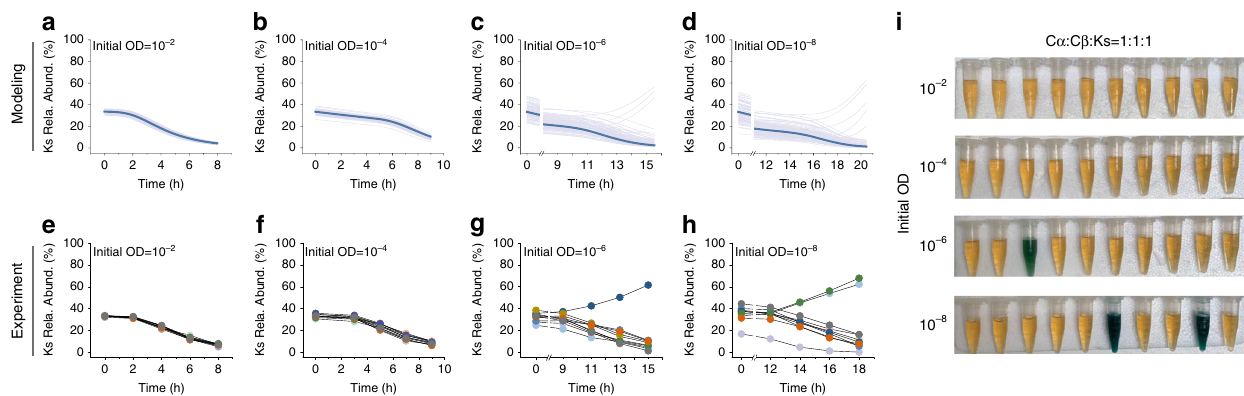
Fig. 4 Divergent ecosystem dynamics directed by cooperation variations from sampling. a – d Model-predicted time courses of Ks abundance in the C α - C β -Ks ecosystem starting with a total initial OD of 10 -2 ( a ), 10 − 4 ( b ), 10 − 6 ( c ), and 10 − 8 ( d ). For each initial OD, a total of 100 simulation replicates were shown. For comparison, the deterministic dynamics of Ks without sampling-induced variability were displayed with bold lines. e – h Experimentally measured population dynamics of Ks in the C α -C β -Ks ecosystem for a total initial OD of 10 − 2 ( e ), 10 − 4 ( f ), 10 − 6 ( g ), and 10 − 8 ( h ). The co-cultures were inoculated at 1:1:1 ratio but different total ODs; for each initial OD, 10 experimental replicates were performed. i Colorimetric assays of the C α -C β -Ks co-cultures from the experiment in e – h . Cultures containing strain Ks turned into blue green due to the cleavage of X-Gluc by beta-glucuronidase from Ks; in contrast, those lacking Ks remains the original culture color (yellow). Each test tube contains only the supernatants of the co-culture after X-Gluc treatment. Source Data available in the source data fi